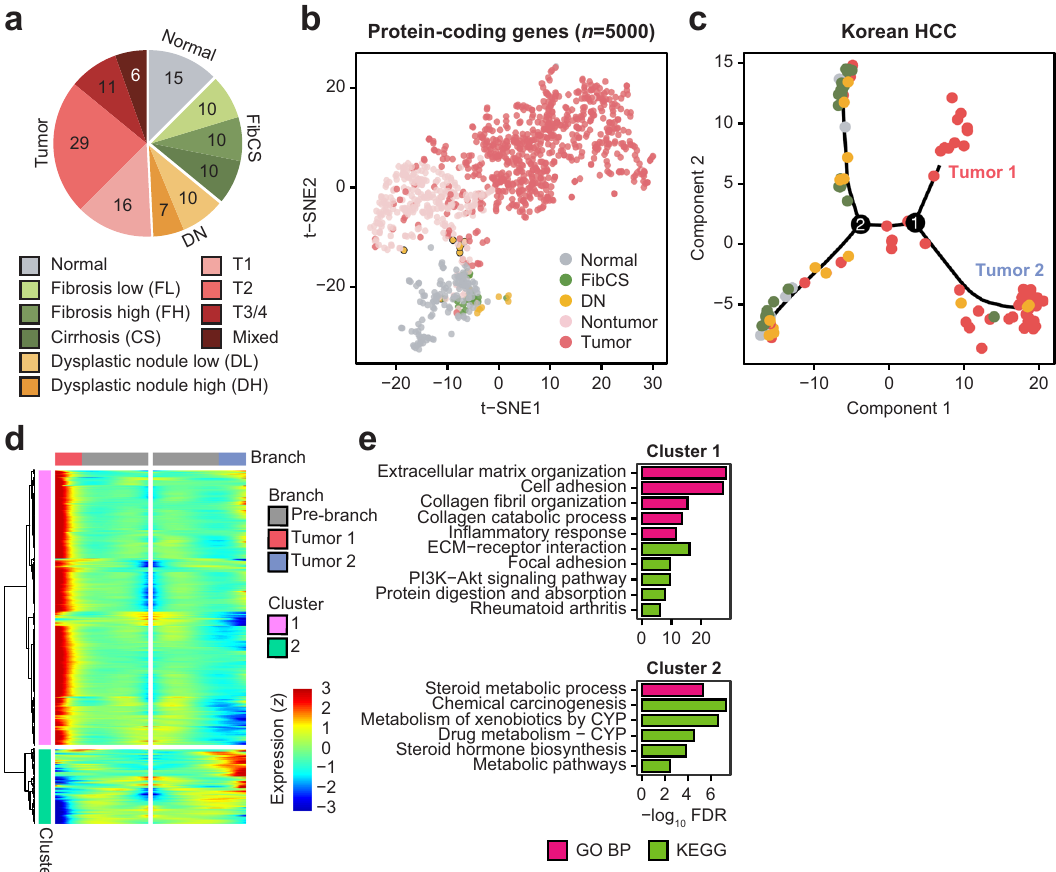
Fig. 1 Overview of Korean HCC cohort characteristics. a Pie chart of the number of samples in each stage of histopathological classi fi cation. T1 ~ 3/4 = T of the TNM staging system; mixed = combined HCC and intrahepatic cholangiocarcinoma. b t-SNE analysis using the 5000 most highly expressed protein-coding genes in the meta-dataset ( n = 1179). c Trajectory analysis of Korean HCC using Monocle 2. Colors are the same as in b . Numbers on the trajectory line indicate branching points. Two paths of tumor samples are noted as Tumors 1 and 2. d Branch expression analysis of two paths (Tumors 1 and 2) of branch 1 in c . e GO terms and KEGG pathways enriched in each cluster in d . The top- fi ve signi fi cant terms ( FDR < 0.05) were